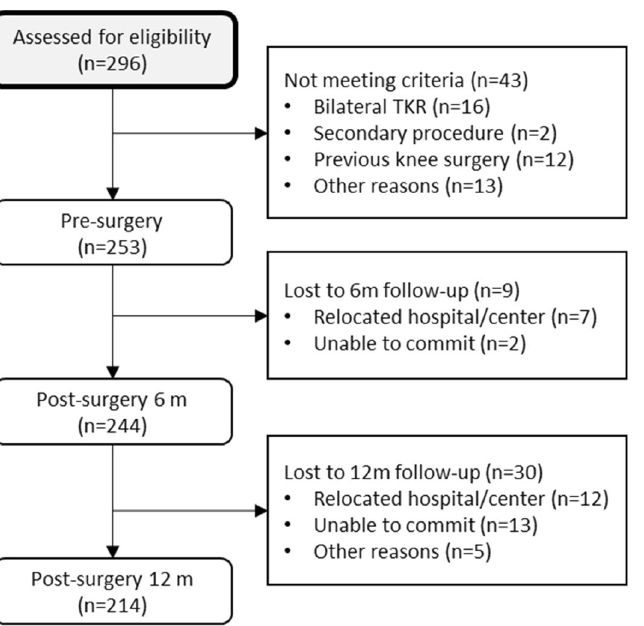
Figure 1. Flowchart of